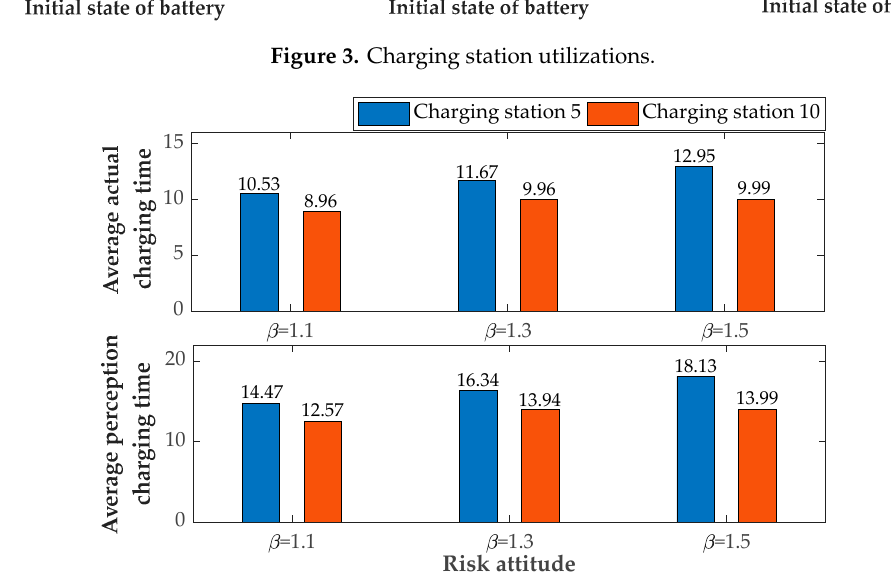
Figure 4. Recharging time information.